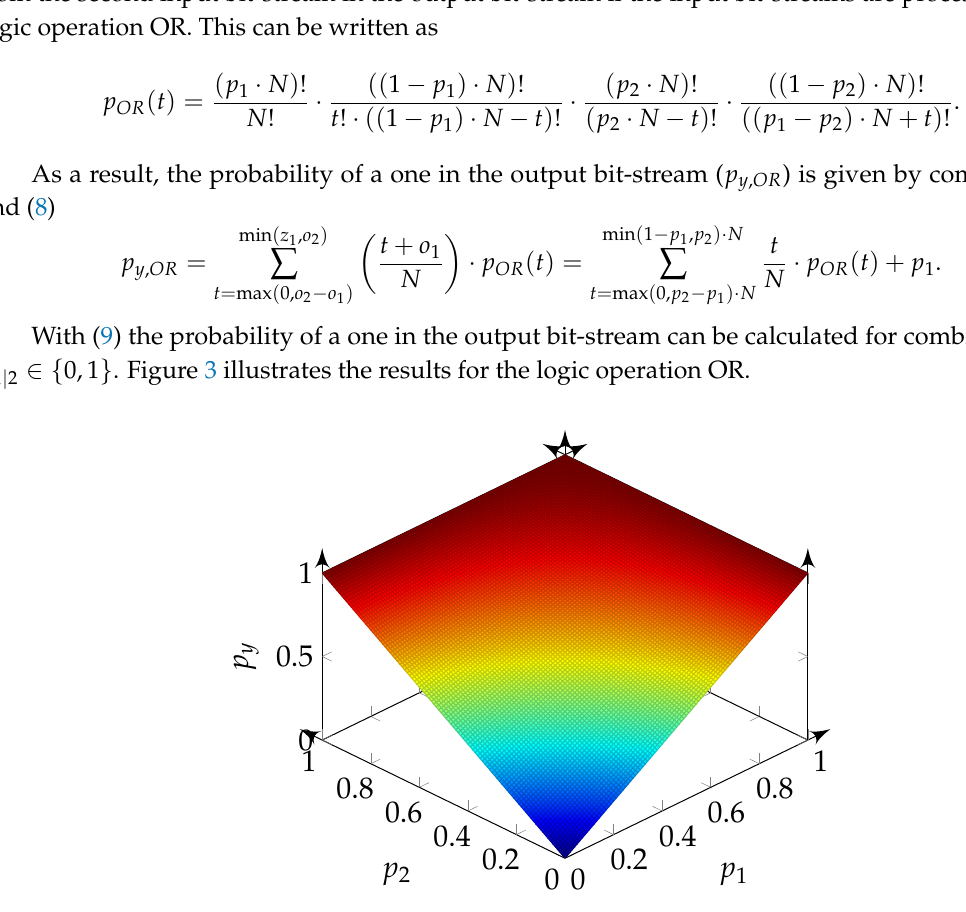
Figure 3. Expected probability of a one in the output bit-stream for the input bit-streams x 1 and x 2 , with the probability of ones p 1 2 , operated by |